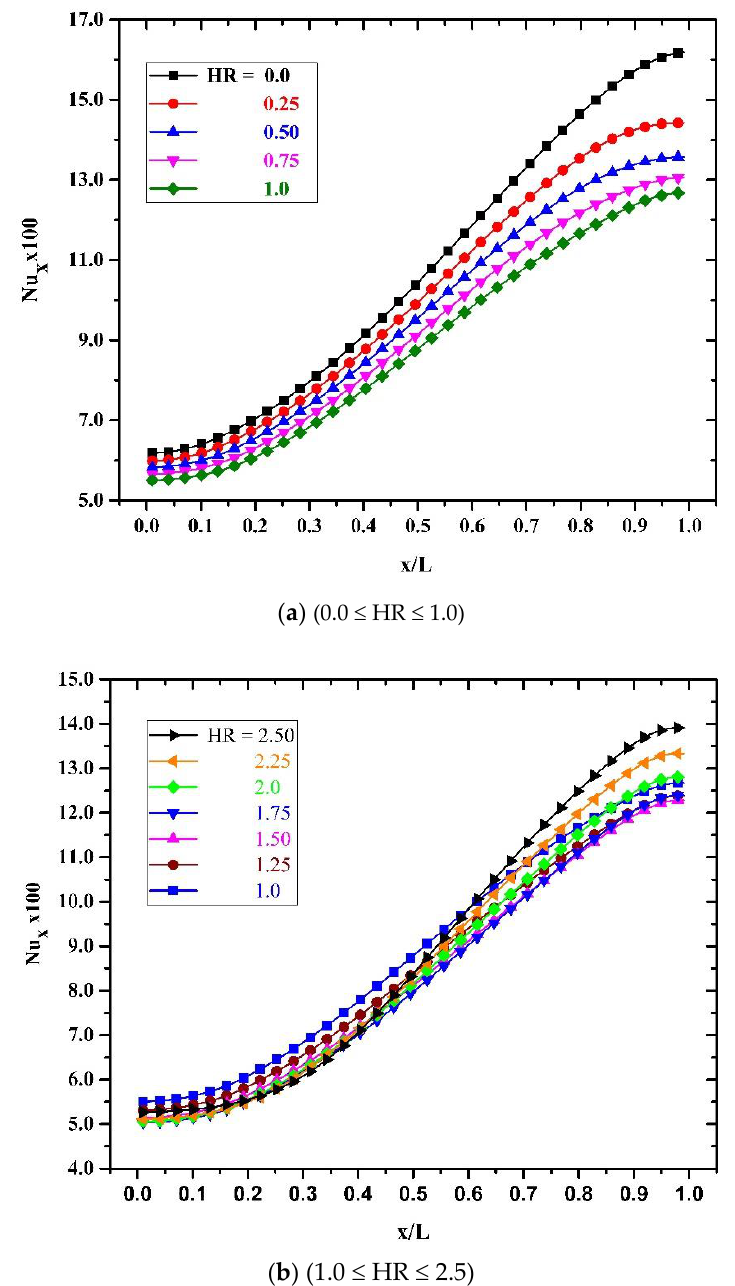
Figure 15. Local Nusselt number distribution along cavity bottom wall at different height ratios.